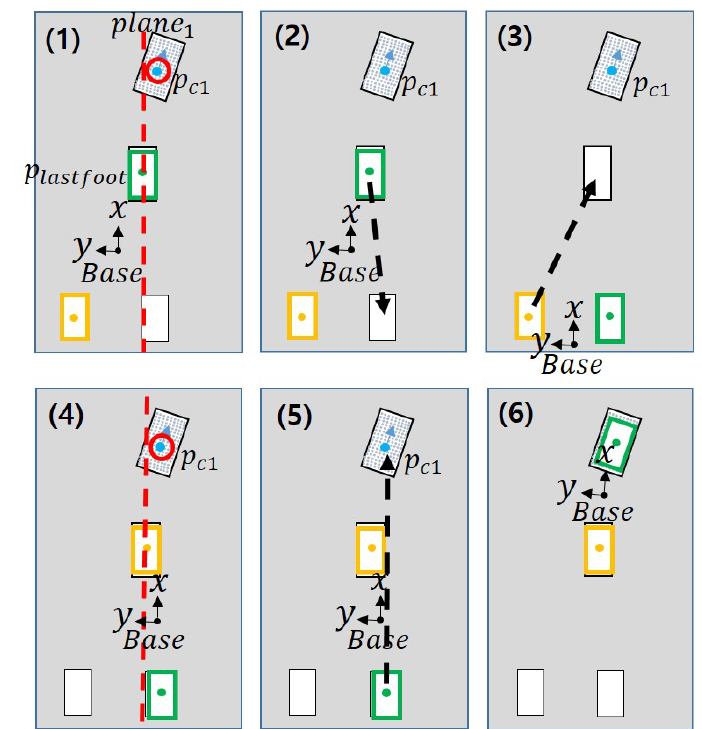
Figure 8. Results when the last swing foot and the swing foot calculated in (1) are the same. ( 1 – 6 ) are the process of selecting footstep and moving.